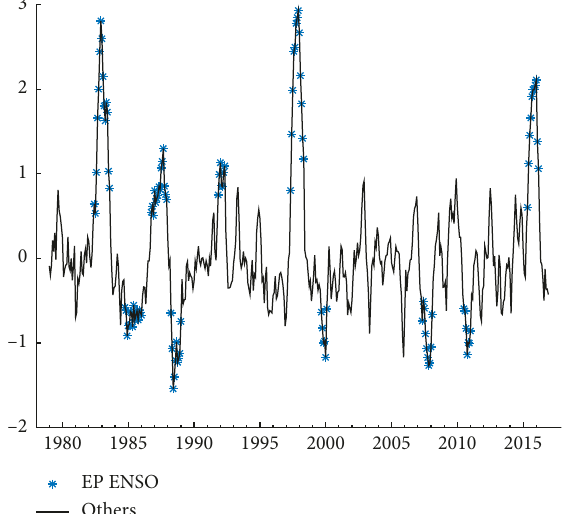
) during 1979–2016. EPI